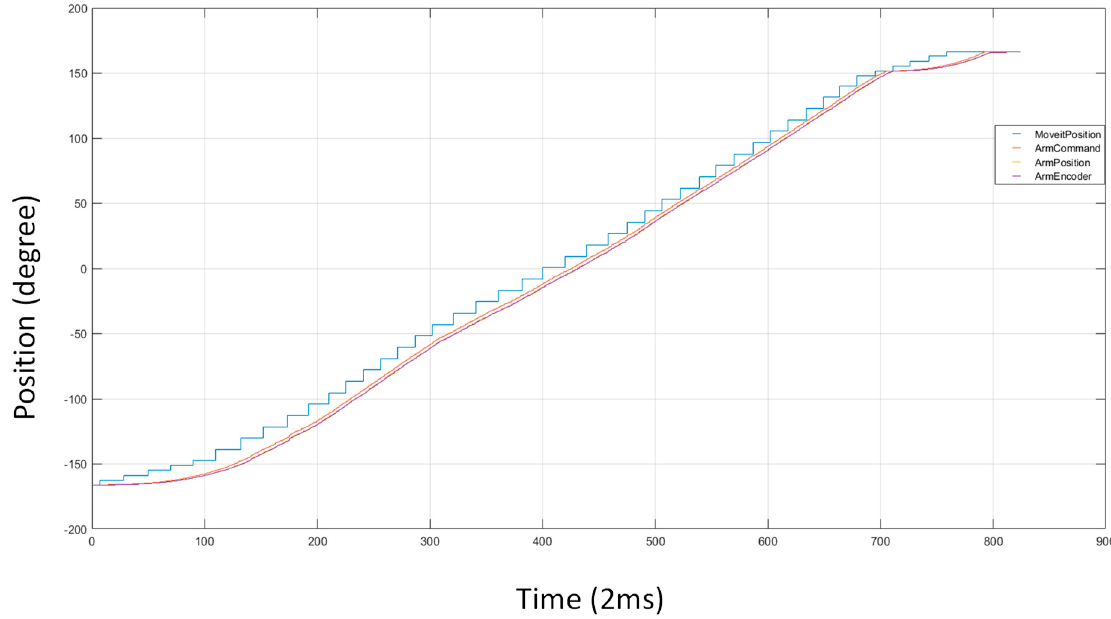
Figure 6. Trajectories of MoveIt planned path (MoveItPosition), command position (ArmCommand), feedback position (Arm Position), and motor encoder (ArmEncoder).